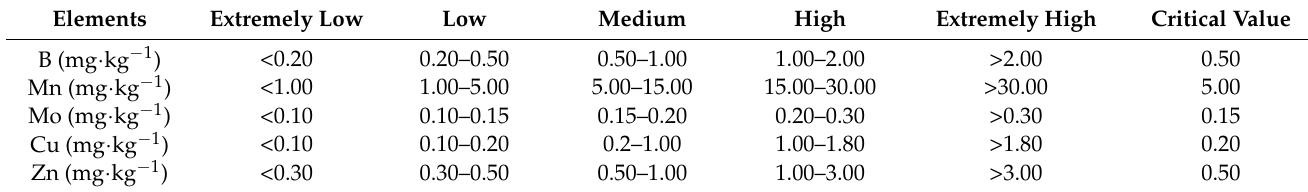
Table 2. Classification standard of soil trace elements in Guangdong